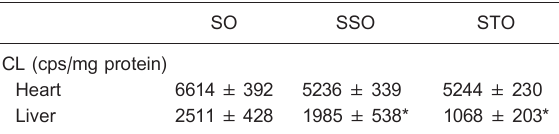
Table 1. Oxidative stress evaluated by chemiluminescence (CL) in sedentary ovariectomized rats (SO), sedentary ovariectomized rats treated with simvastatin (SSO), and trained ovariectomized rats treated with simvastatin